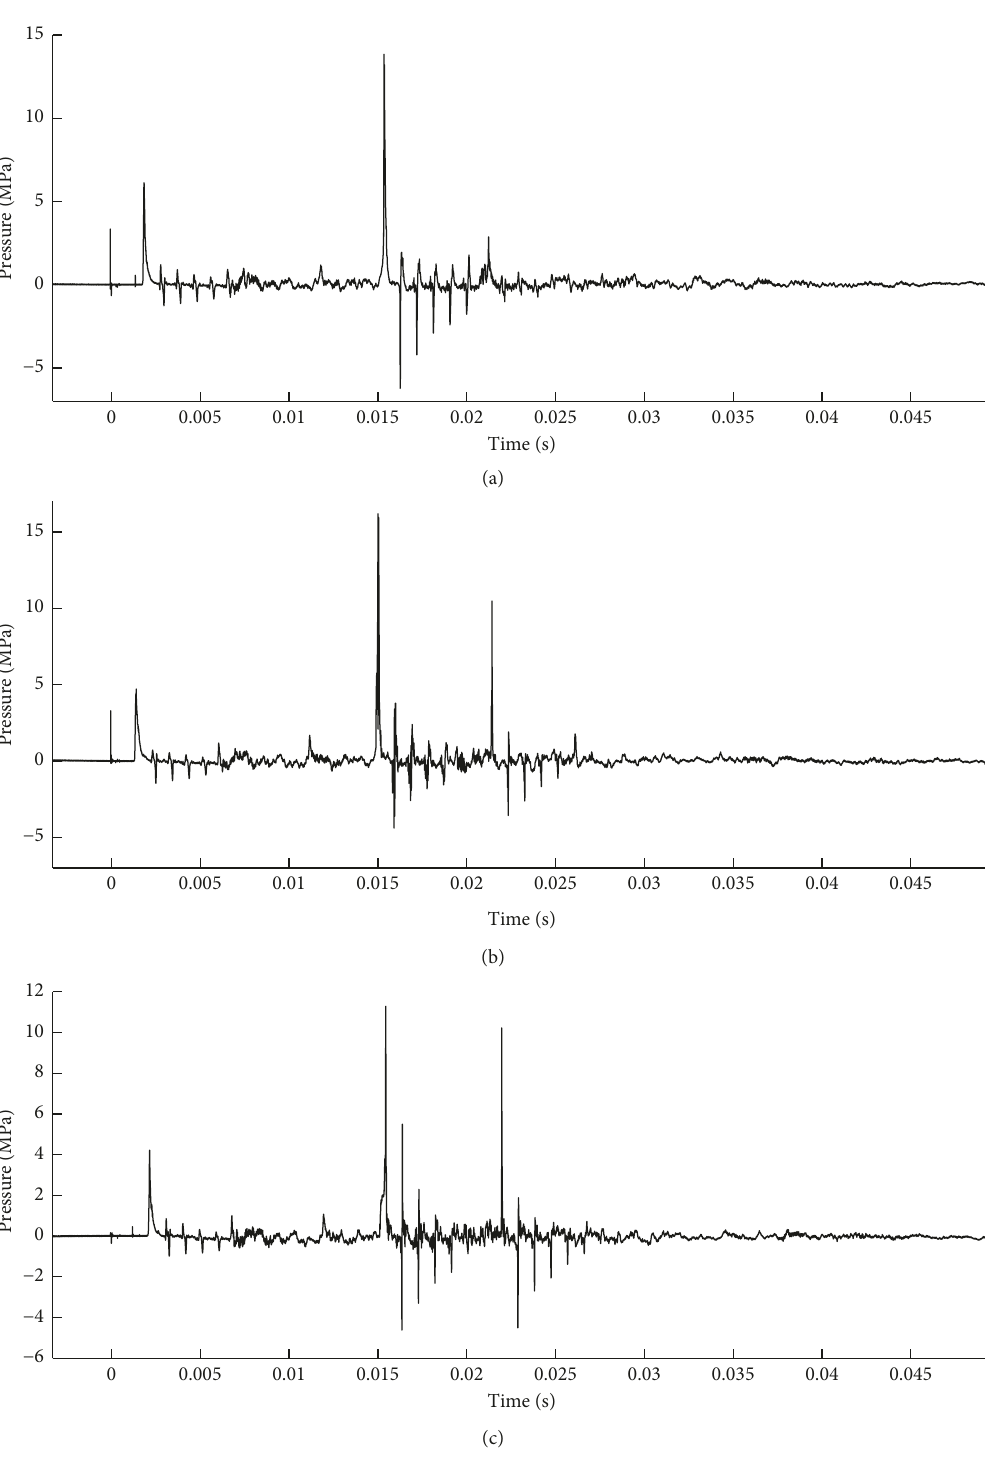
Figure 13: Pressure-time profile recorded by HPB with (a) 10 mm, (b) 15 mm, and (c) 20 mm